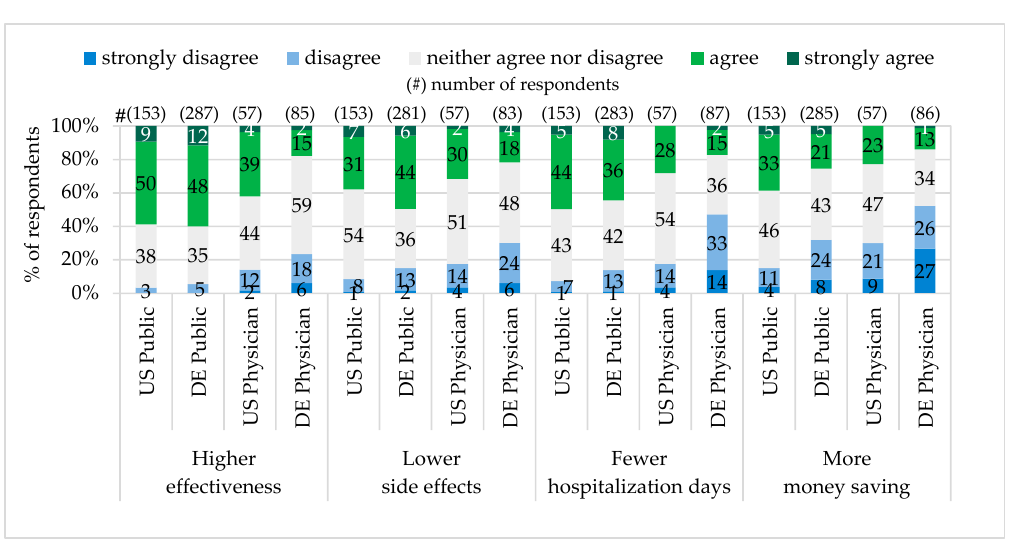
Figure 6. Perceived Personalized Drug Advantages.